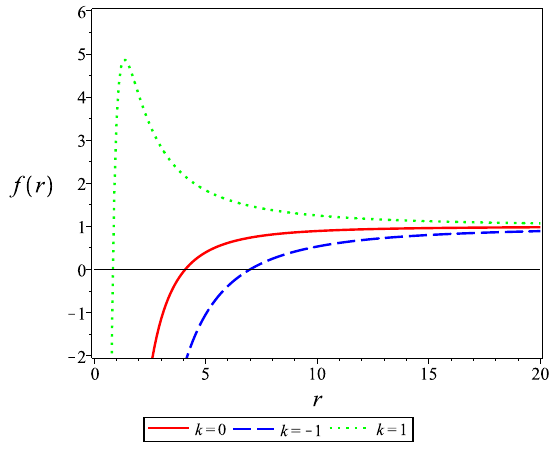
Figure 1 . f ( r ) versus r for n = 5 , G = 1 , α = 3 , M = 5 and x = 1 for “ − ” sign branch.